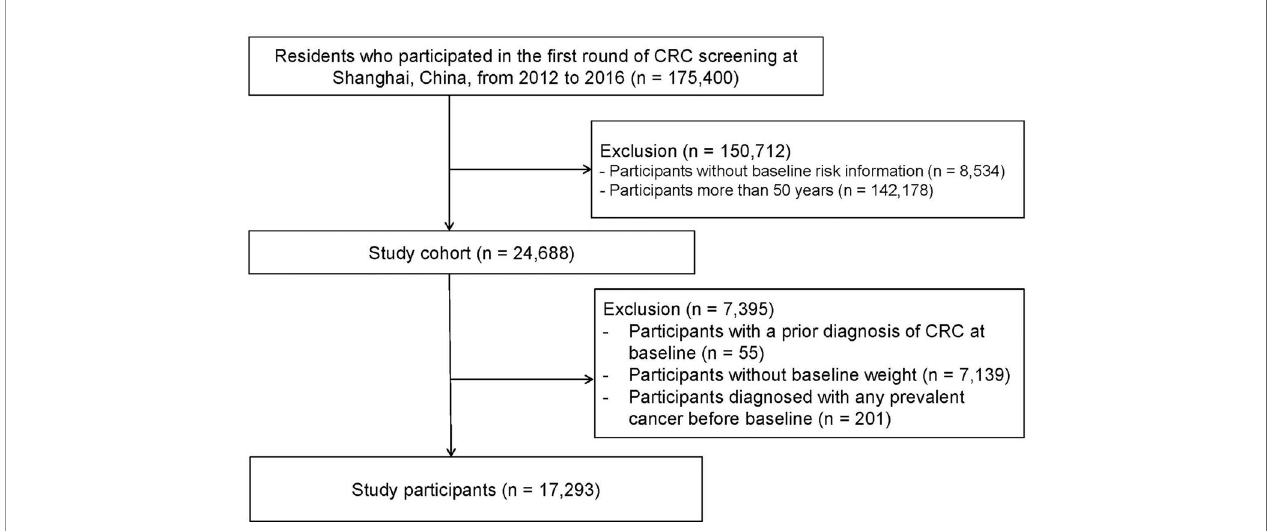
FIGURE 1 | Flow diagram for selection of study cohort and